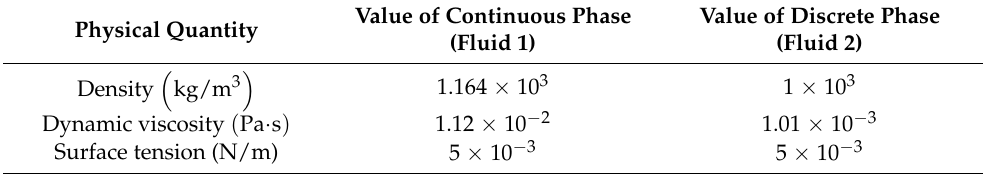
Table 1. Physical properties of two-phase flow.